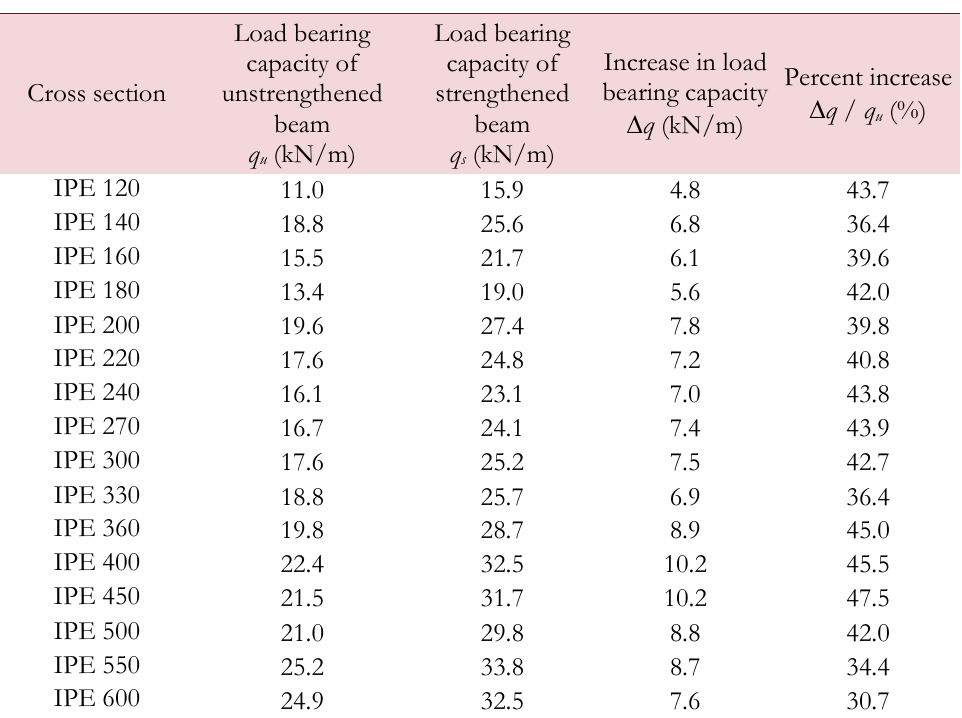
Table 5: Load bearing capacity of the